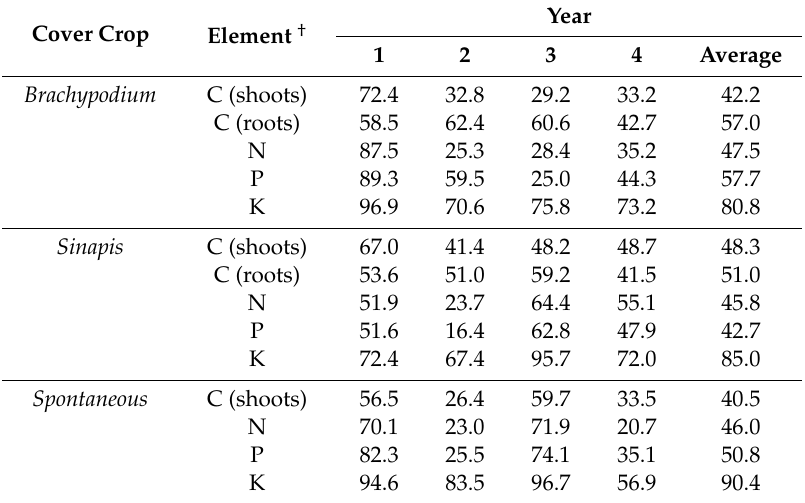
Table 5. Percentage of nutrient released per cover crop and